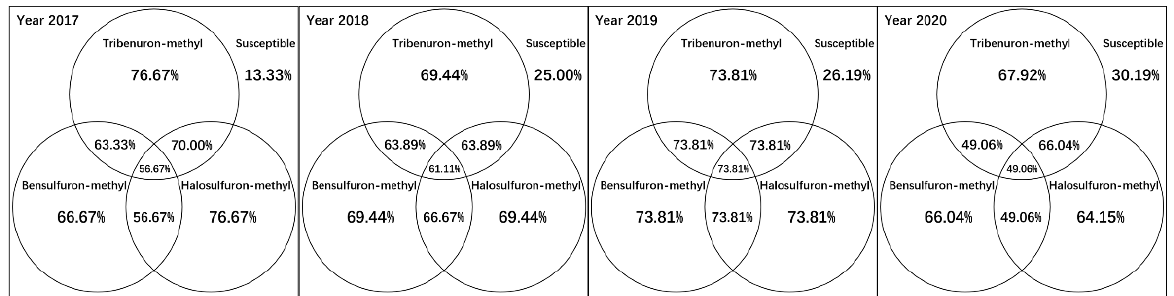
Figure 2. Proportion of cleavers seeds characterized as resistant (>20% survival) or having low resistance (2% to 19% survival) to three ALS-inhibiting sulfonylurea herbicides (tribenuron-methyl, bensulfuron-methyl and halosulfuron-methyl), and the proportion of seeds that were completely susceptible (<2% survival) to all three herbicides from 2017, 2018, 2019 and 2020. For tribenuron-methyl and bensulfuron-methyl, 63.33% of populations had resis- tance and low resistance to both herbicides; 30.00% of populations had resistance to both herbicides; and 20.00% of populations were sensitive to both ingredients (Figure 2). For tribenuron-methyl and halosulfuron-methyl, 70.00% of populations had resis- tance and low resistance to both herbicides; 23.33% of populations had resistance to both herbicides; and 16.67% of populations were sensitive to both ingredients (Figure 2). For tribenuron-methyl, bensulfuron-methyl and halosulfuron-methyl, 56.67% of pop- ulations had resistance and low resistance to all herbicides; 16.67% of populations had resistance to all herbicides; and 13.33% of populations were sensitive to all the ingredients (Figure